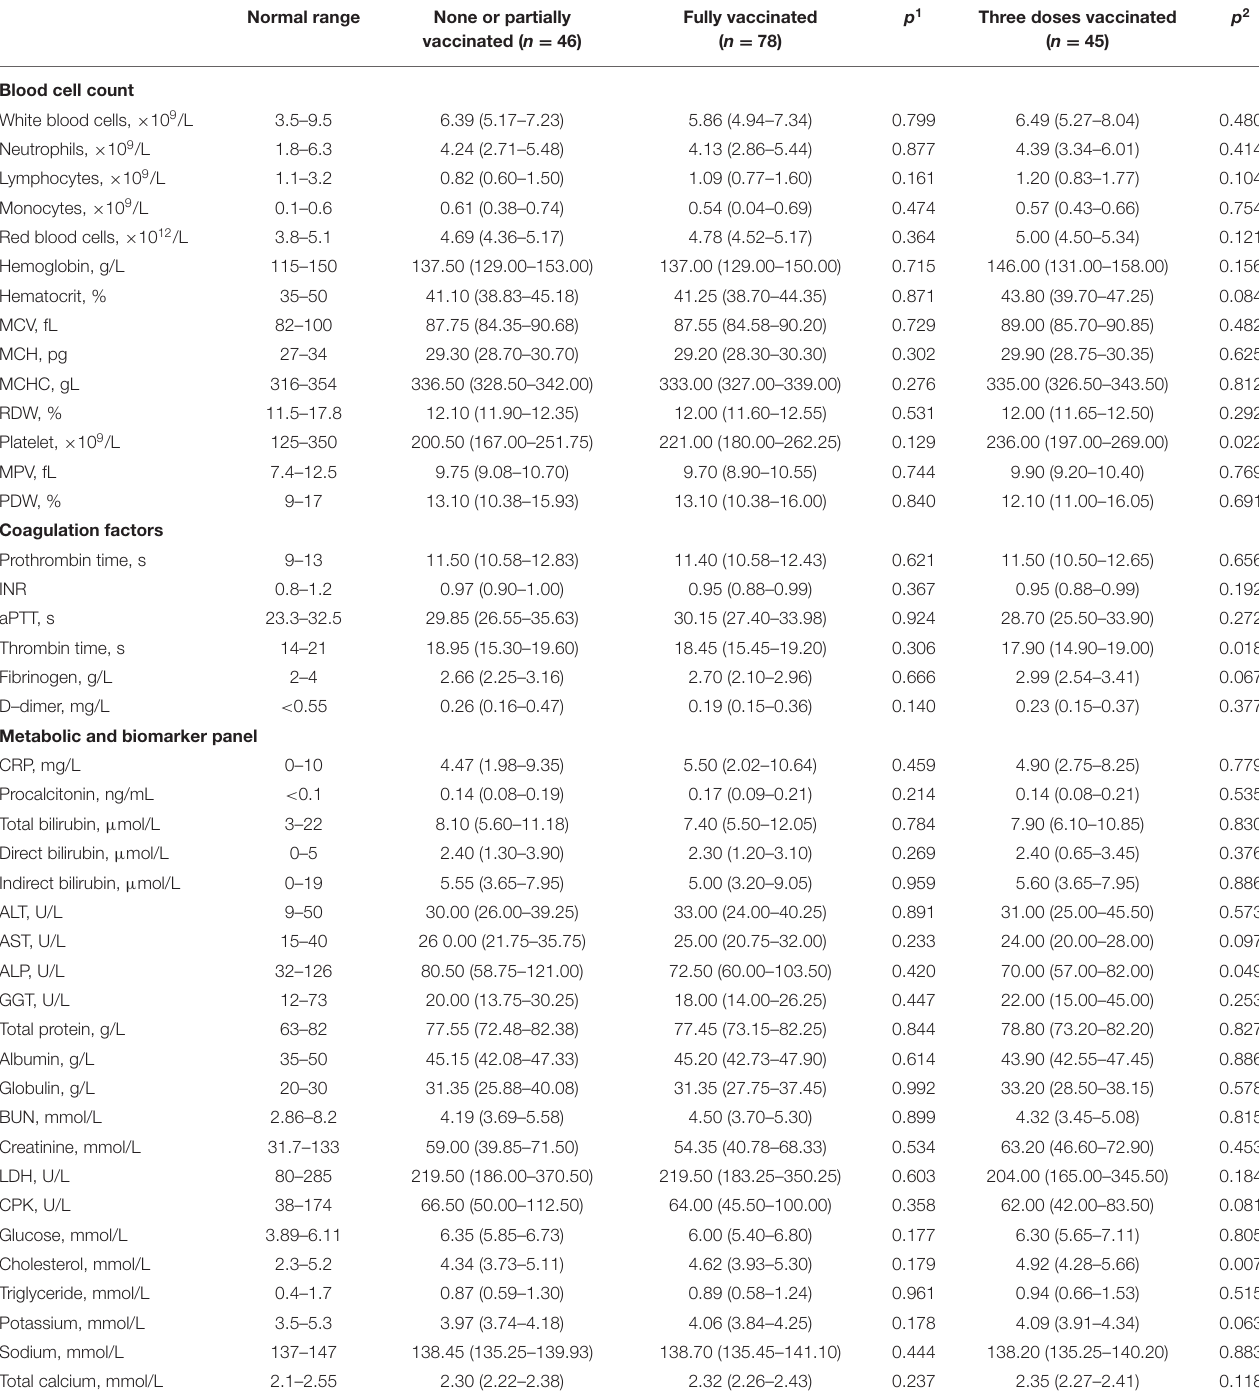
TABLE 3 | The hematological profiles of COVID-19 patients infected by the omicron variant were divided into three subgroups and thereby compared between patients with none or partial vaccination and patients with full vaccination (exhibited by p 1 values), or between patients with none or partial vaccination and patients with three-dose vaccination (exhibited by p 2